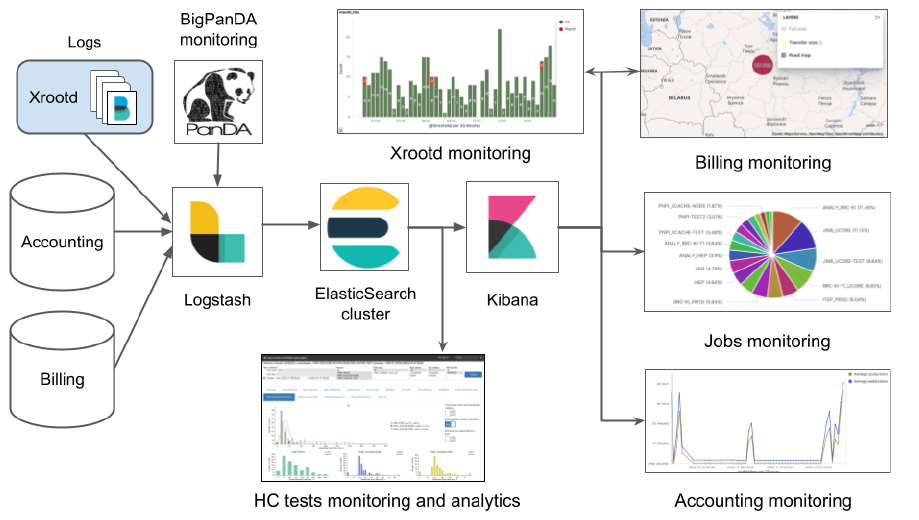
Figure 3. The unified monitoring system